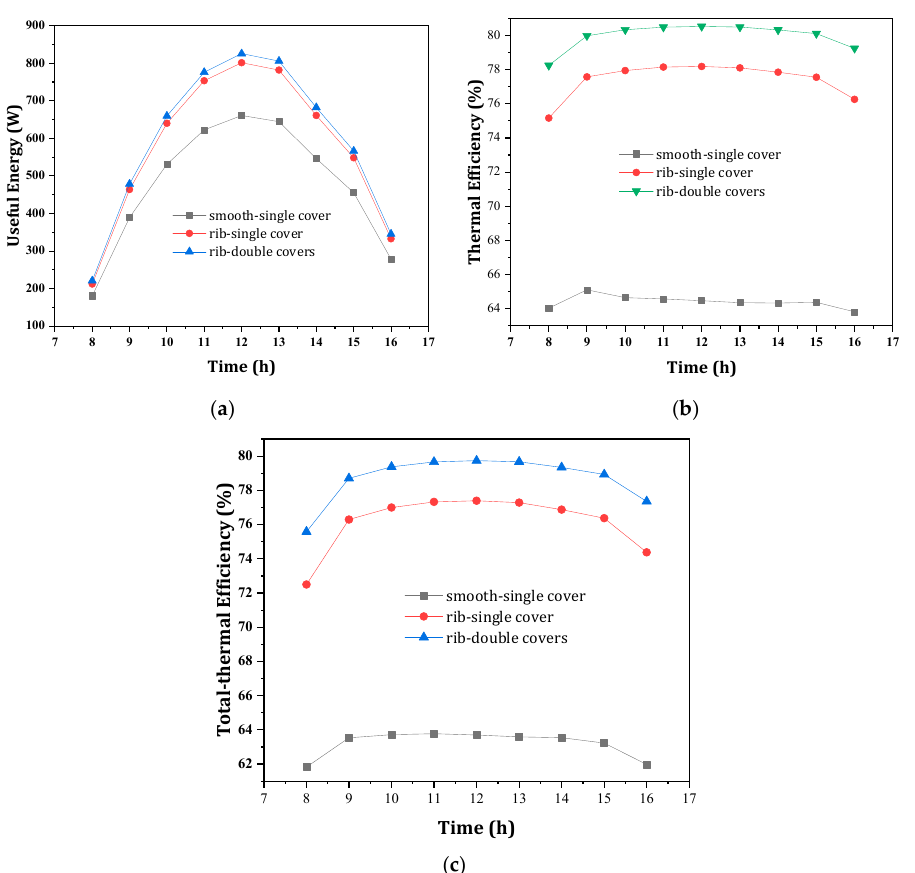
Figure 11. Useful energy ( a ), thermal efficiency ( b ), and total thermal efficiency ( c ) versus daytime for smooth, V-rib roughened with single cover, and V-rib roughened with double cover SAH surfaces at Re =